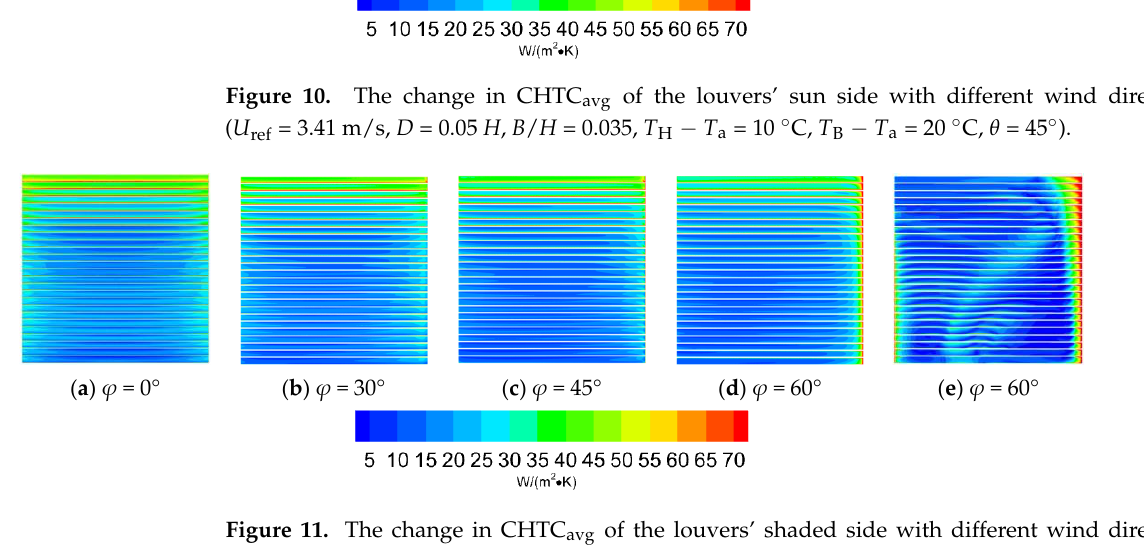
Figure 11. The change in CHTC avg of the louvers’ shaded side with different wind directions ( U ref = 3.41 m/s, D = 0.05 H , B / H = 0.035, T H − T a = 10 °C, T B − T a = 20 °C, θ = 45°).